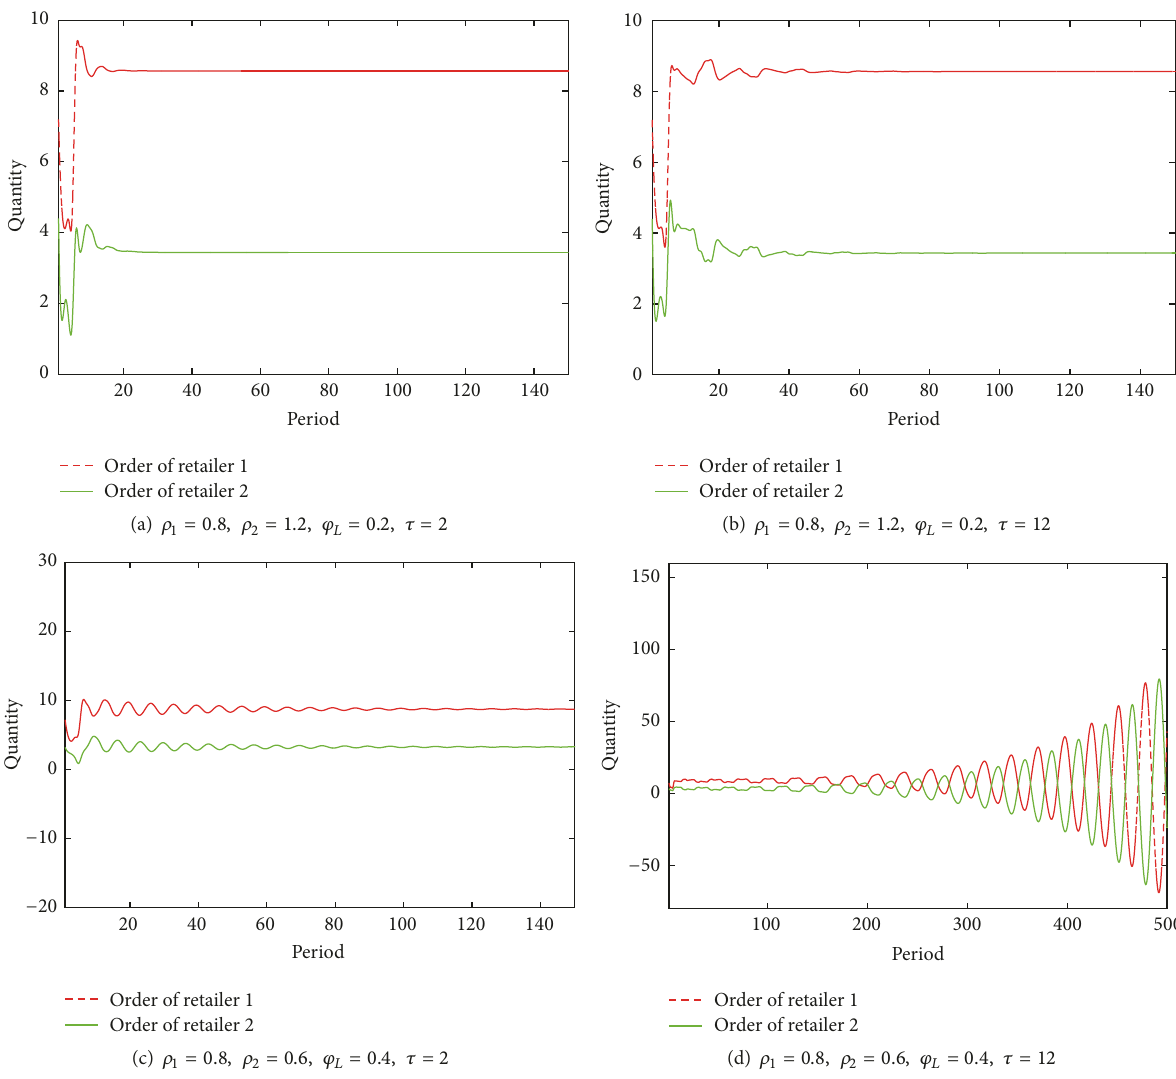
Figure 4: Stability validation for Theorem